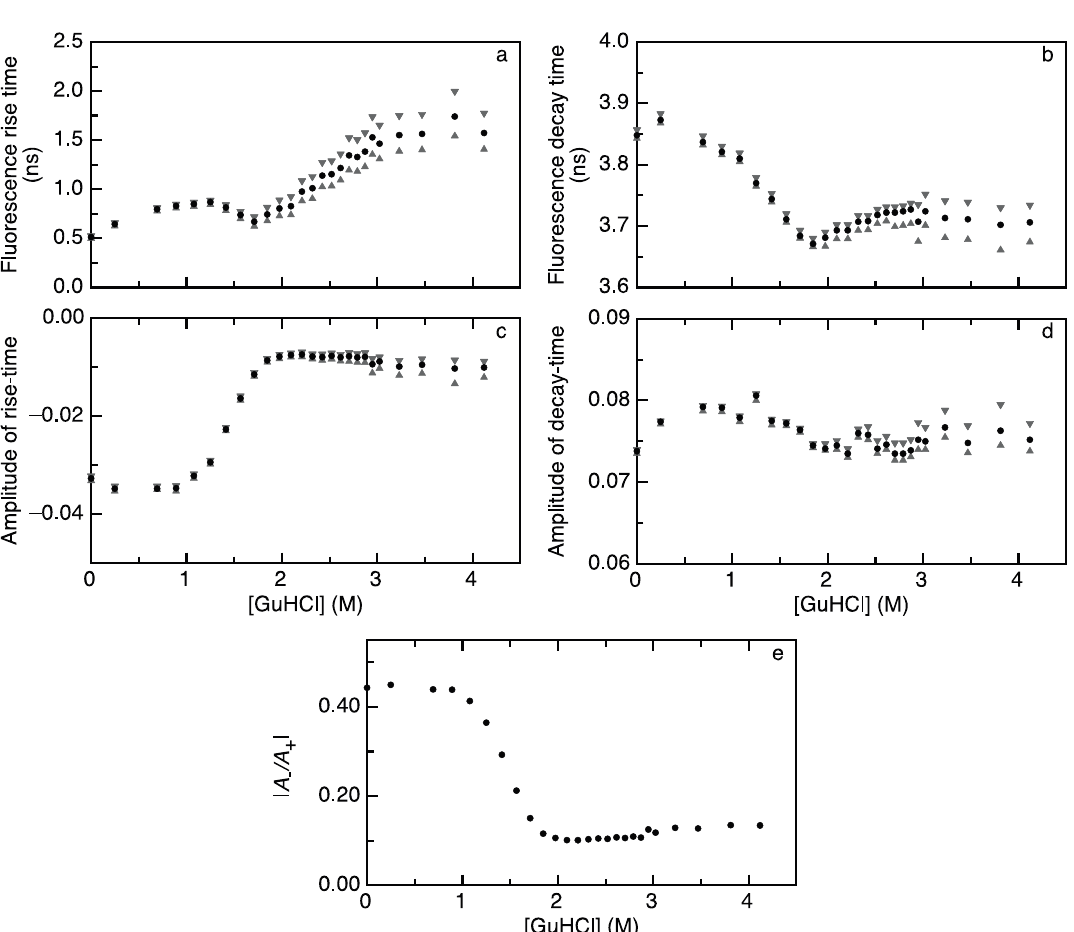
Figure 2. Denaturant-dependencies of rise and decay times of acceptor fluorescence upon donor excitation track folding of apoflavodoxin labeled with A488 (donor) and A568 (acceptor). In all panels, black dots represent fitted values and grey triangles represent confidence limits. ( a ) The rise time of acceptor fluorescence and ( b ) decay time of acceptor fluorescence reveal the biphasic dependencies on GuHCl; ( c ) The amplitude of the acceptor fluorescence rise time ( A − ) changes in a monophasic manner as a function of GuHCl; ( d ) The amplitude of acceptor fluorescence decay ( A + ) is virtually constant as a function of denaturant concentration; and ( e ) The absolute ratio of the amplitudes of fluorescence rise and decay time (| A − / A + |) shows a monophasic dependence on denaturant